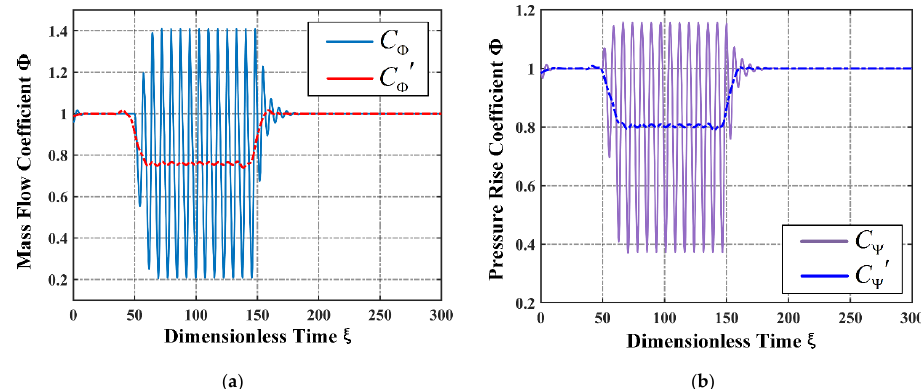
Figure 8. The effect of Savitzky-Golay smoothing filter: ( a ) Mass flow instability coefficient; ( b ) Pressure rise instability coefficient.